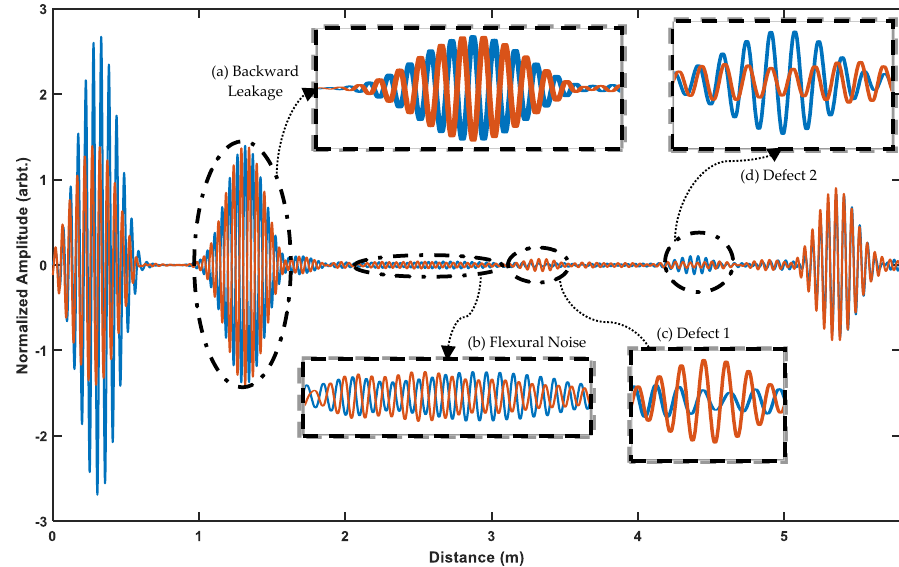
Figure 11. FEM signals (30 kHz) where two defect regions and the flexural noises are marked where blue and red lines show the first and second sets of the signals respectively.